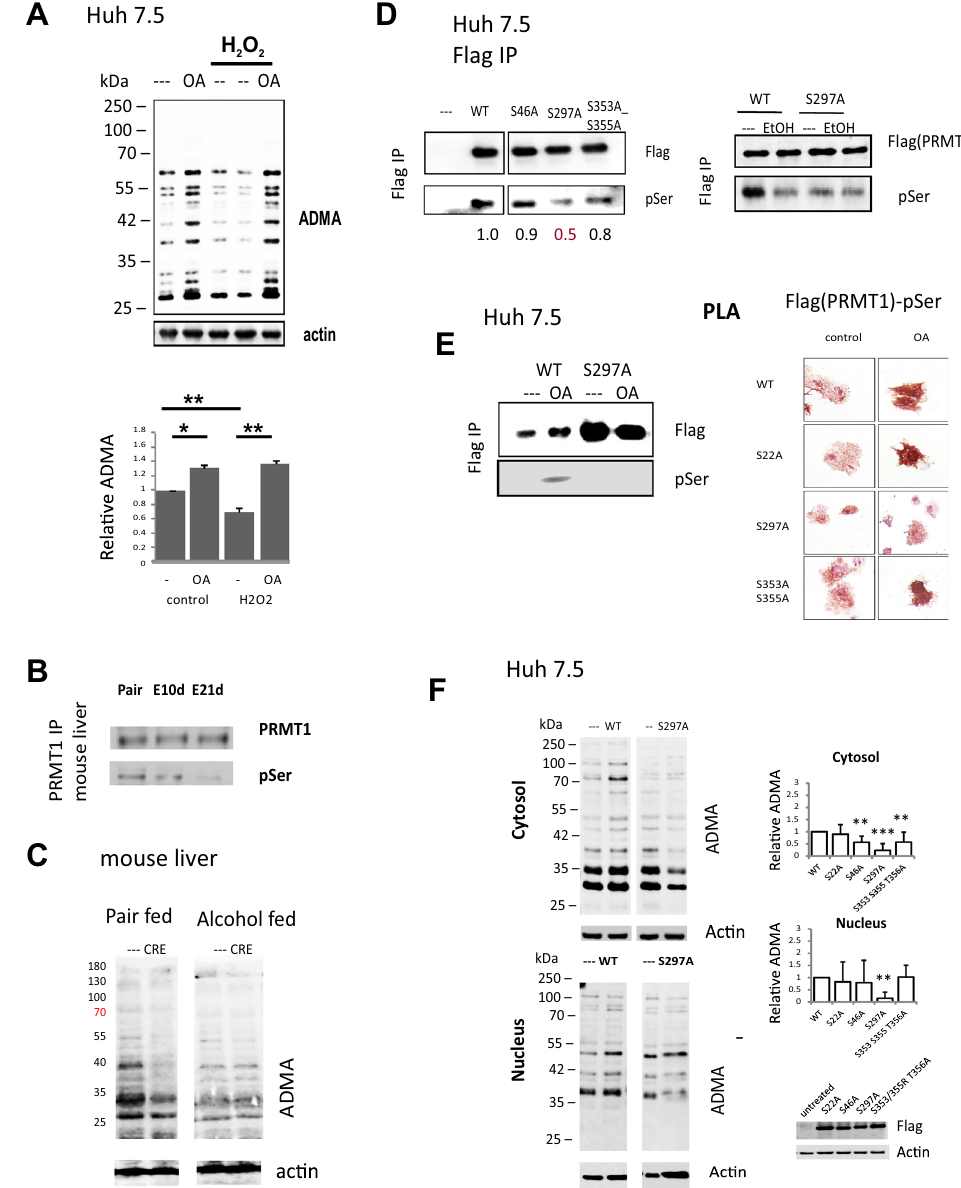
Figure 4. Alcohol promotes PRMT1 dephosphorylation. (A) Representative image of western blot analysis of ADMA levels in Huh 7.5 cells treated with 100 µ M hydrogen peroxide for 24 hours and PP2A inhibitor 2 nM Okadaic acid (OA) for 8 hours where indicated. Bottom. Densitometry analysis of N = 3 independent experiments. ** p < 0.01. ( B) PRMT1 was immunoprecipitated from mouse liver extracts of mice fed either control liquid diet (pair) or alcohol liquid diet for 10 days or 3 weeks (E10d or E21d). Representative western blot analysis of immunoprecipitated PRMT1 protein using anti-PRMT1 and anti-phospho-serine antibodies. ( C) Representative image of western blot analysis of ADMA levels in liver sections of mice as in Fig. 1. ( D) Western blot analysis of PRMT1 wild type or mutants purified from Huh 7.5 cell treated with 50 mM ethanol where indicated using anti-Flag and anti-phospho-serine antibodies. ( E) Left. Western blot analysis of PRMT1 wild type or mutants purified from Huh 7.5 cells untreated or treated with Okadaic acid (OA) where indicated using anti-Flag and anti-phospho-serine antibodies. Right. Representative images of proximity ligation assay in Huh7.5 cells transfected with Flag-PRMT1 wild type of the mutants and treated with Okadaic acid (OA) where indicated using anti-Flag and anti-phospho-serine (MAPK CDK substrate specific) antibodies. ( F) Representative image of western blot analysis of ADMA levels in nuclear and cytosolic fractions of Huh 7.5 cells untransfected or transfected with PRMT1 wild type or mutants. Right. Densitometry analysis of N = 3–5 independent experiments. ** p < 0.01, *** p < 0.001. ADMA was normalized to the level of ADMA in PRMT1 wildtype transfected cells, 0 – level in untransfected